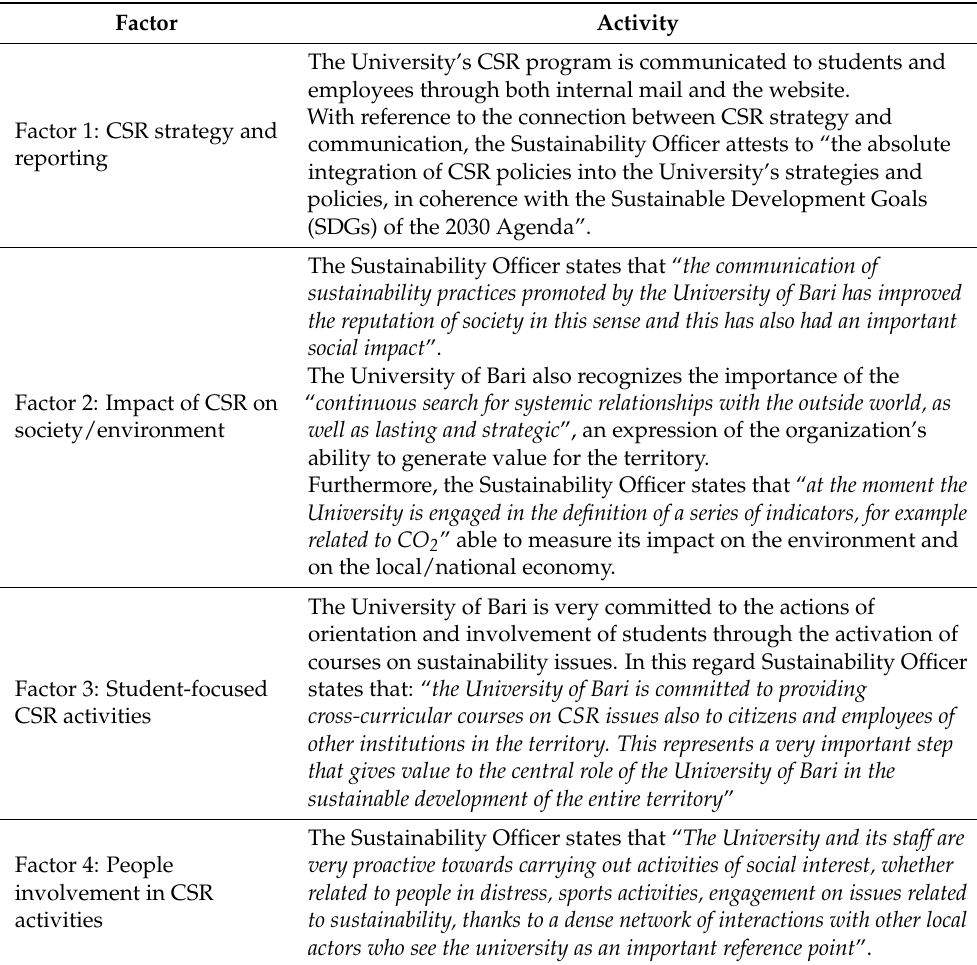
Table 2. Summary of results for each of the analysis factors of CSR in universities according to the framework of Antonaras et al.